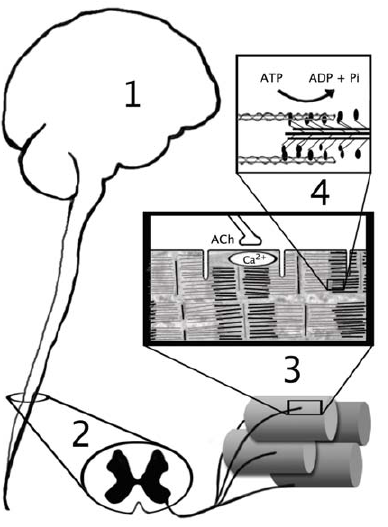
Figure 1. Pathway of Voluntary Torque Production. Physiological events necessary for voluntary torque production are modeled by components in the present computational model. 1) Excitation in the motor cortex 2) a motor neuron activation, 3) sarcolemmal depolariza- tion, calcium release, 4) cross-bridge formation and muscular force development. Reproduced from: Kent-Braun J.A., Fitts R.H., Christie A. ‘‘Skeletal Muscle Fatigue’’ In: Comprehensive Physiology, Wiley-Black- well, 10.1002/cphy.c110029, 2(2):997–1044, 2012.